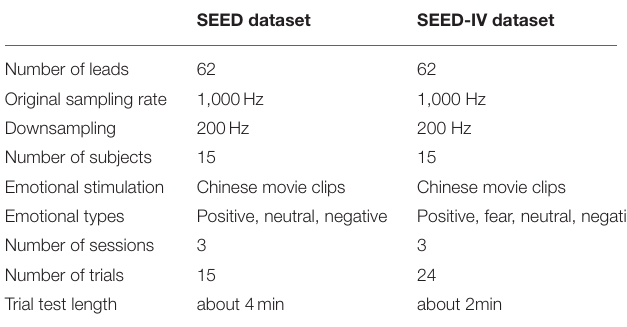
TABLE 1 | Specification comparison between the SEED and SEED-IV